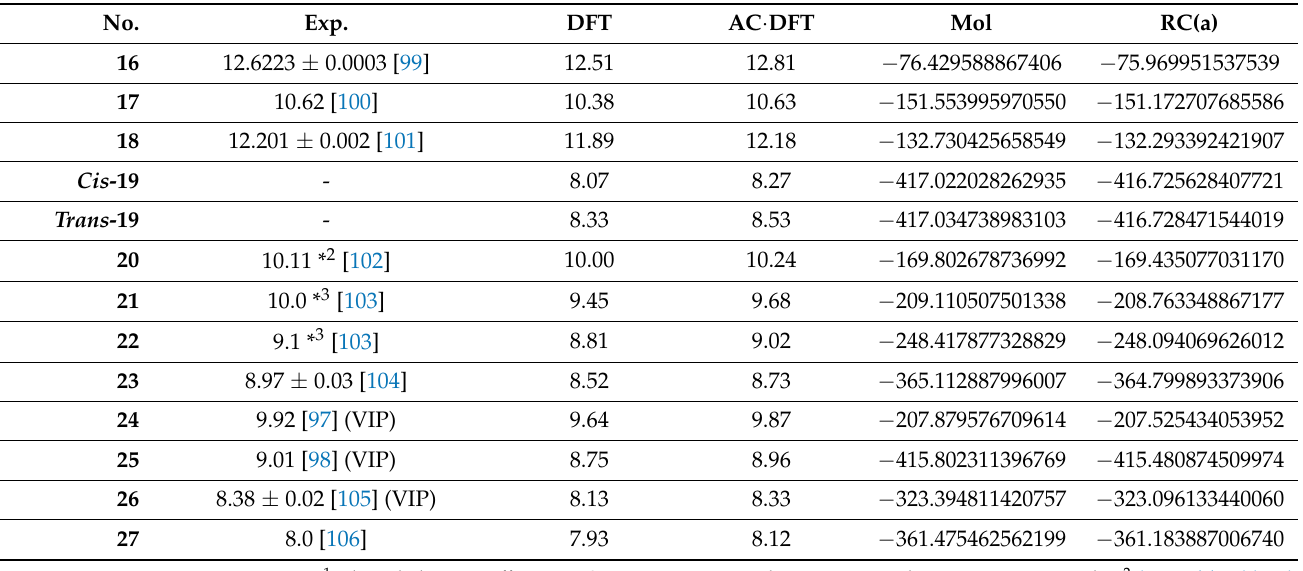
Table 5. Experimental and DFT calculated adiabatic ionization potential (AIP, eV) and DFT calculated energies (E, E h ) of molecules ( Mol ) and radical cations ( RC ) of compounds 16 – 29 * 1